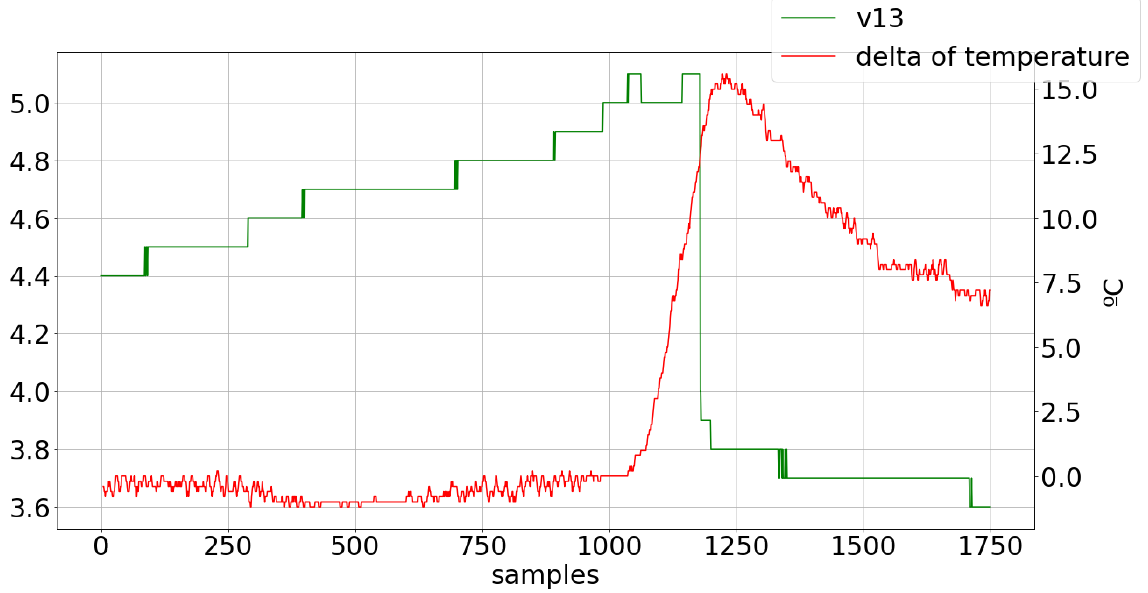
Figure 9. The behavior of the temperature and voltage of the cell during the OC abuse. After a long time and a voltage close to 5 V, the temperature